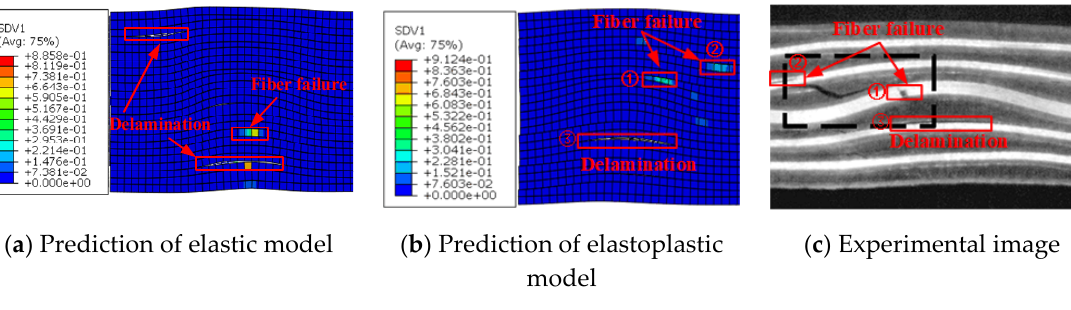
Figure 18. Damage locations for a specimen with wrinkle level 11.4° ( a ) predicted by the elastic model, ( b ) predicted by the proposed elastoplastic model, and ( c ) test image [10].